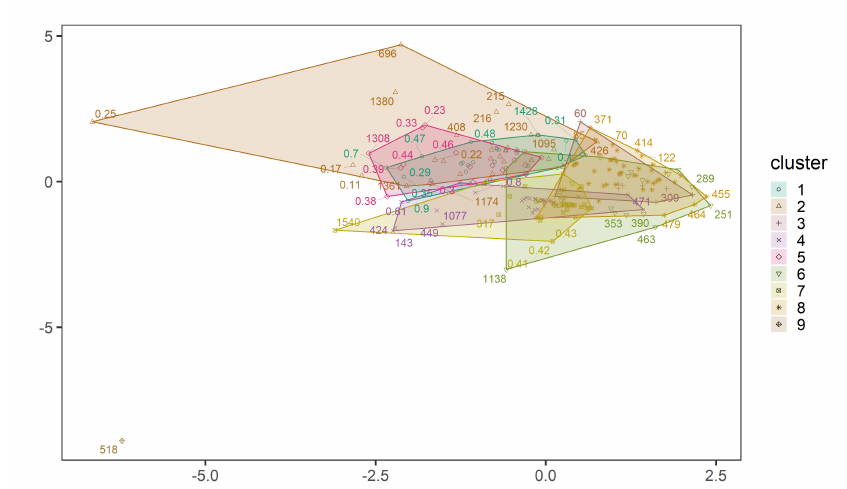
Figure 3. Clustering based on integrated life cycle (OE and embodied) impacts parameters (scenario 3). Numbers indicate the buildings